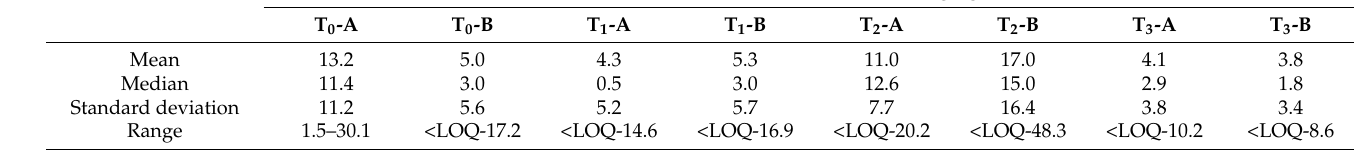
Table 8. Statistical analysis of the data for histamine concentrations in pet-food samples after storage in different environmental conditions.